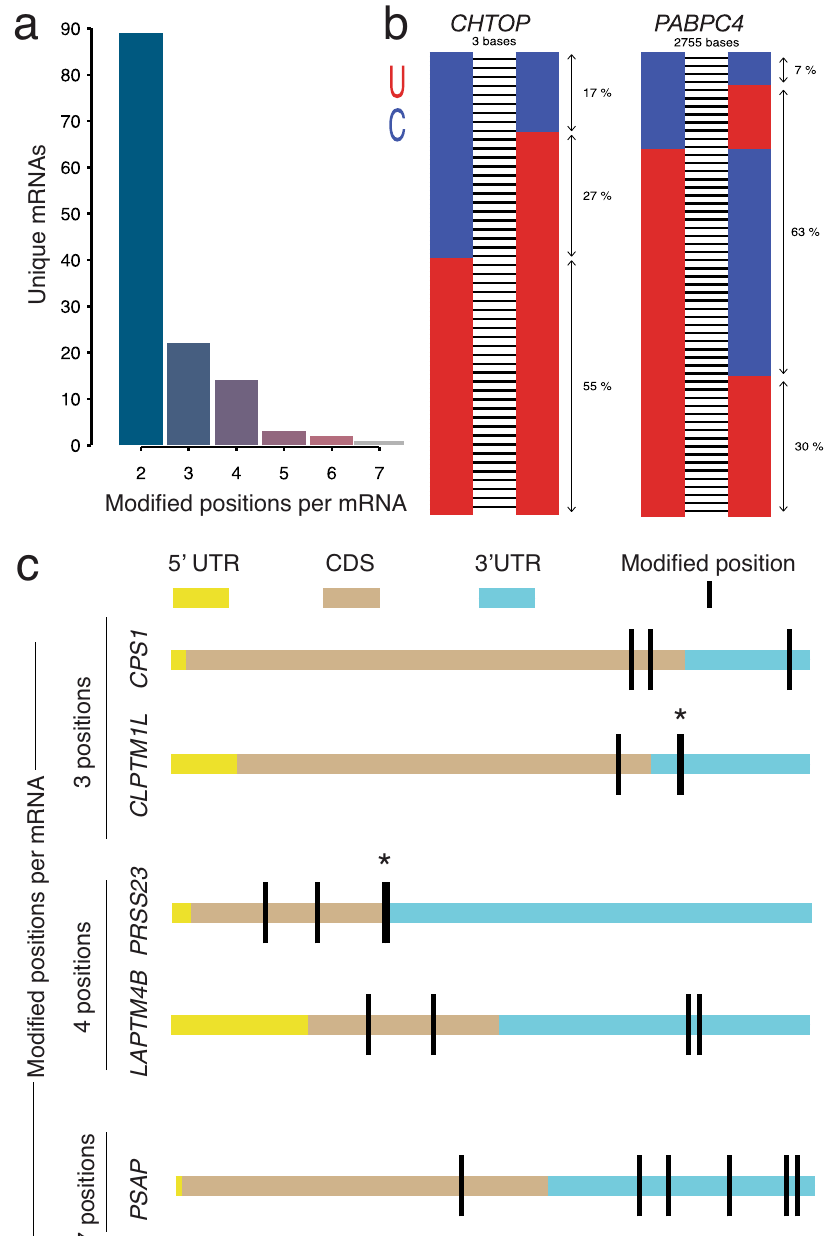
Fig. 6 | Type II hypermodi fi cation is de fi ned as the mRNA targets that contain two or more uridine-modi fi ed positions. a Unique mRNAs that are classi fi ed as hypermodi fi cation type II positions and the number of modi fi ed positions pos- sible on each. b Two examples of hypermodi fi ed type II transcripts ( CHTOP –